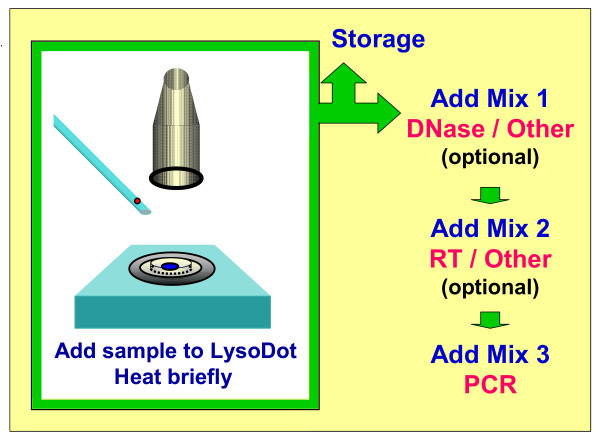
Easiness and versatility of the PurAmp method. In a streamlined version of the procedure, LysoDots (20 nl or less, see Methods for a definition) are dispensed to the lids of PCR tubes resting on a heating block. The LysoDots are quickly dried before adding the samples in a minimal volume of PBS. A second brief heating reduces the lysed samples to the semi-dry state, ready for storage or immediate processing, which may include a variable number and type of enzymatic reactions prior to the final PCR step. This will be a real-time PCR assay when quantification of the templates is desired.